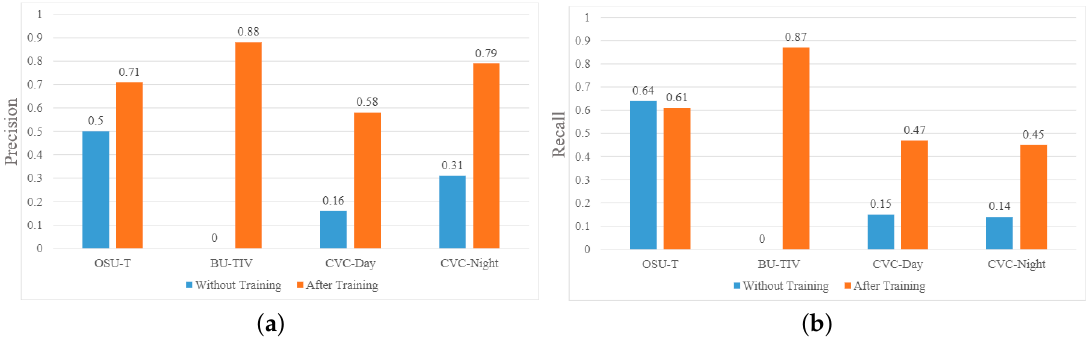
Figure 5. ( a ) Precision and ( b ) recall measures of different training weights on publicly available datasets. Here, the blue bars are the results tested by our thermal training weights, and orange bars are the results tested by our thermal training weights and further training by adding only 5% of the new dataset for 100